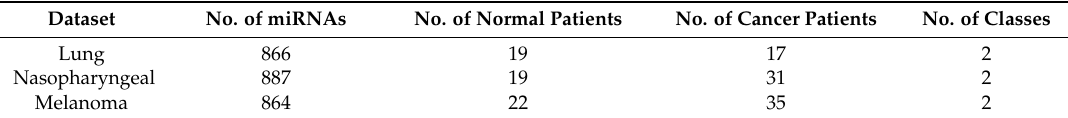
Table 1. The main properties of benchmark